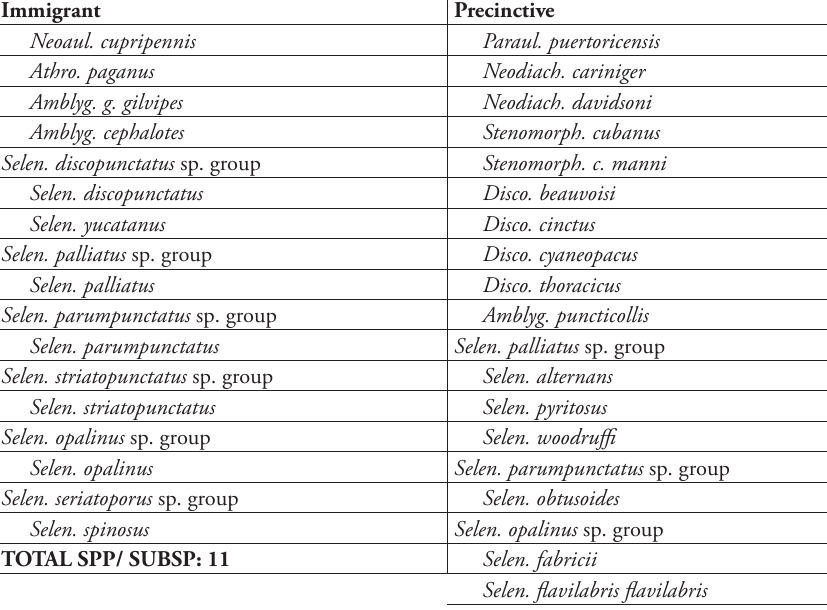
Table 6. West Indian Selenophorine taxa: immigrants and precinctives.